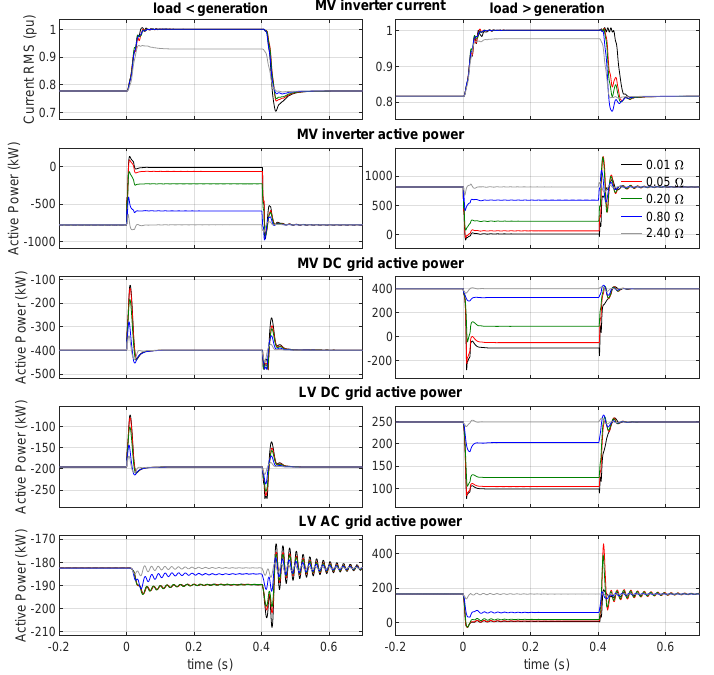
Figure 17. Current and active power in the ST’s MV inverter and active power in the hybrid AC/DC grid following balanced three-phase faults in the HV AC grid for the considered fault resistances.